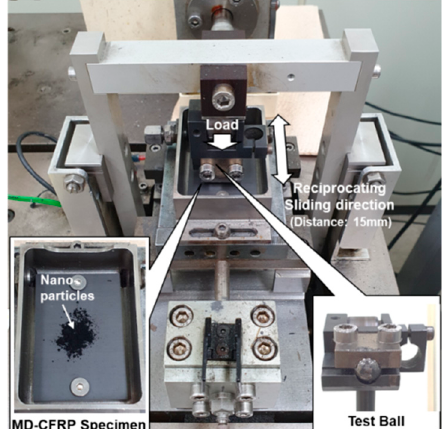
Figure 3. Ball on plate test equipment. Table 2. Information on carbon fiber and prepreg